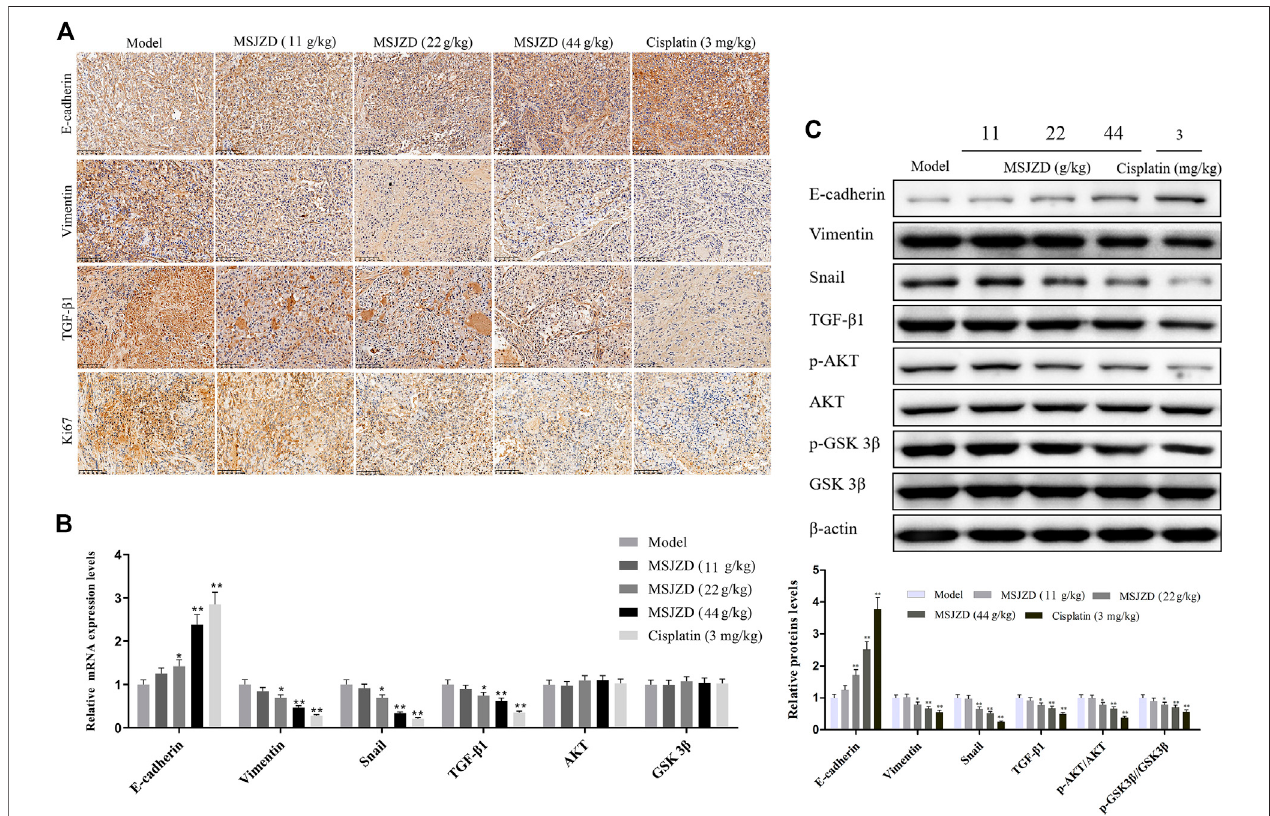
FIGURE 8 | MSJZD restrained EMT, AKT/GSK3 β pathway, and TGF- β 1 expression in A549 tumor-bearing nude mice. (A) Immunohistochemical (IHC) staining of xenograft tumors. (B) The mRNA expression levels of E-cadherin, Vimentin, Snail, TGF- β 1, AKT, and GSK3 β in the experimental groups were determined by qRT-PCR. (C) Theexpression levels ofE-cadherin,Vimentin, Snail,TGF- β 1, p-AKT, AKT, p-GSK 3 β and GSK 3 β in theexperimental groupsweredeterminedby western blot. * p < 0.05, ** p < 0.01. versus the model